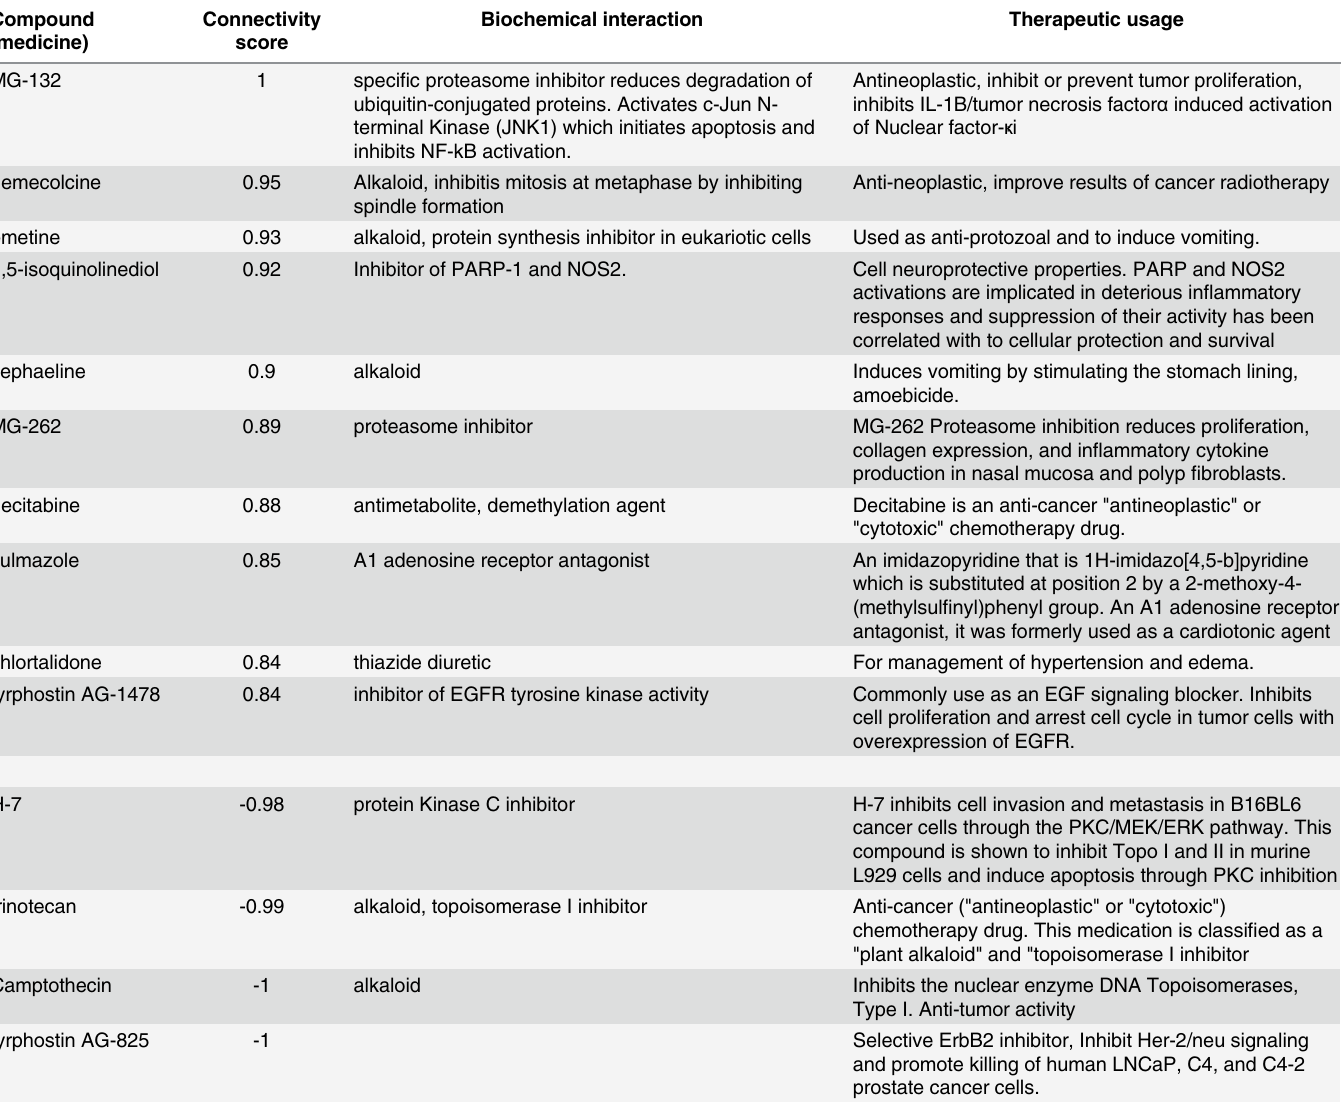
Table 4. Connectivity-map analysis results for the interventions of healthy adults with Lactobacillus rhamnosus GG. Compound